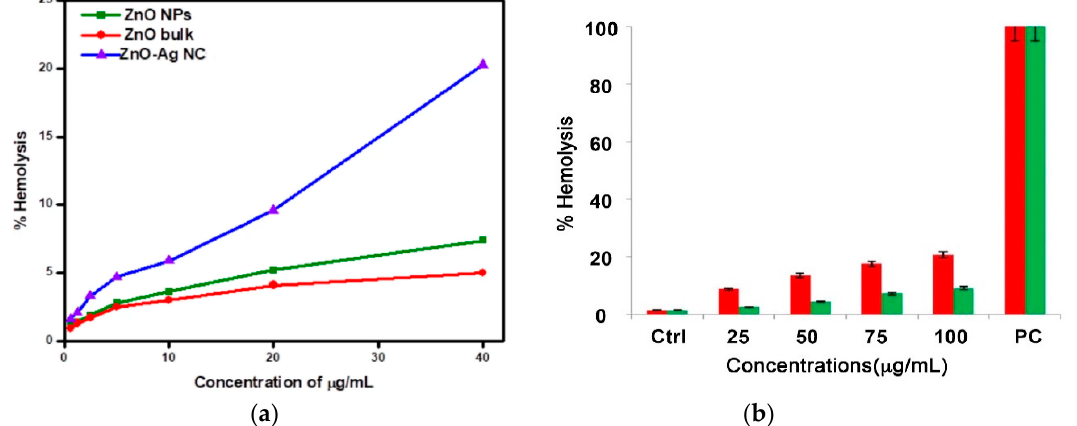
Figure 47. ( a ) The hemolytic activity of bulk ZnO, biosynthesized ZnO NPs and AgNPs/ZnO nanocomposite. Reproduced from [282] under the terms of Creative Commons License. ( b ) Percentage hemolysis of ZnO nanoparticles prepared by biosynthesis (green column) and co- precipitation (orange column). 0.1% Triton X-100 was employed as a positive control (PC). Reproduced from [328] with permission of